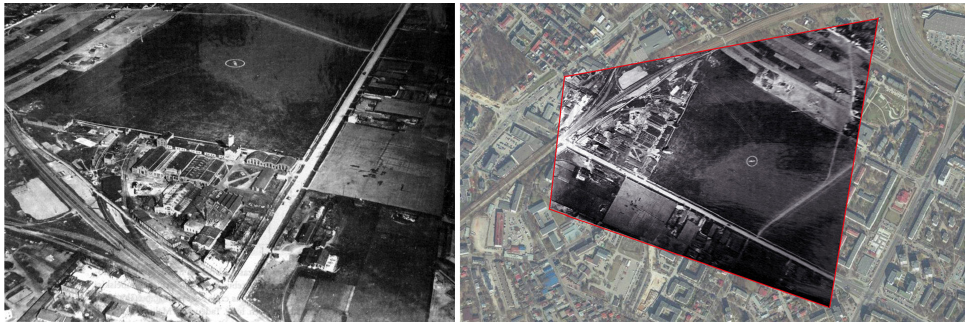
Fig. 7. Left − aerial photograph from 1930–1935, the E. Plage and T. Laśkiewicz’s Aircraft Factory in Lublin and the adjacent aerial field. Right – photograph after calibration. The irregular, trapezoidal area of the photo’s coverage is caused by the high tilt of the camera during the taking of the photo. Own compilation based on the collection of